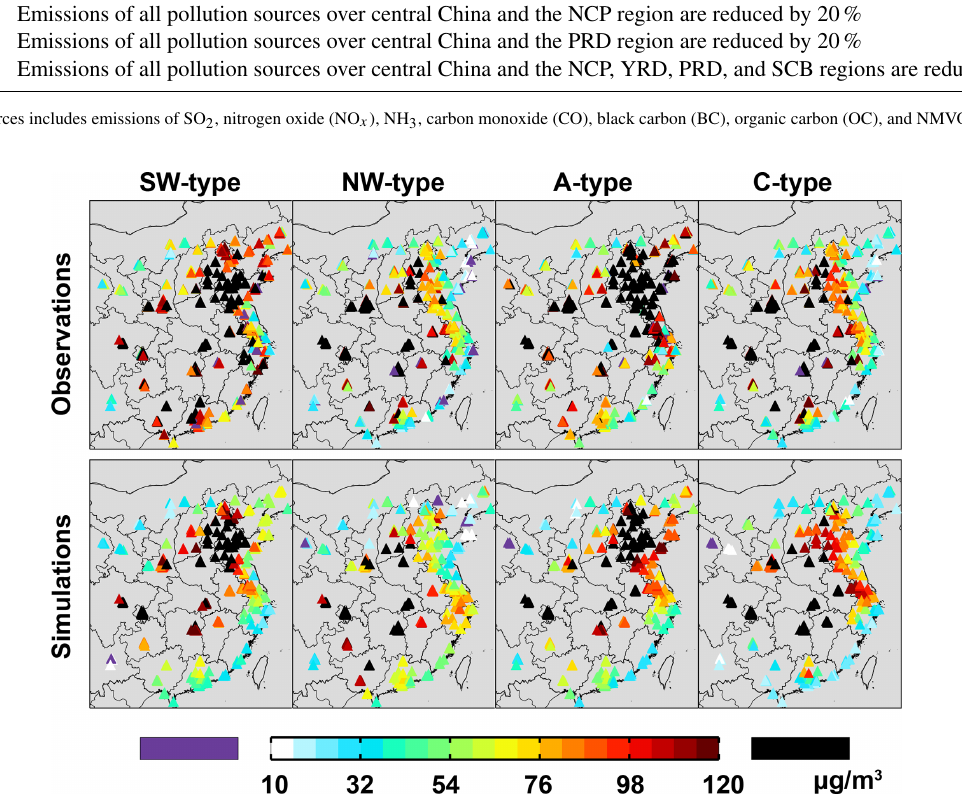
Figure 6. Spatial distribution of observed (top row) and modeled (bottom row, by CON case) PM 2 . 5 concentrations (µg / m 3 ) averaged over four severe pollution episodes controlled by a SW-type (first column), NW-type (second column), A-type (third column), and C-type (fourth column) synoptic